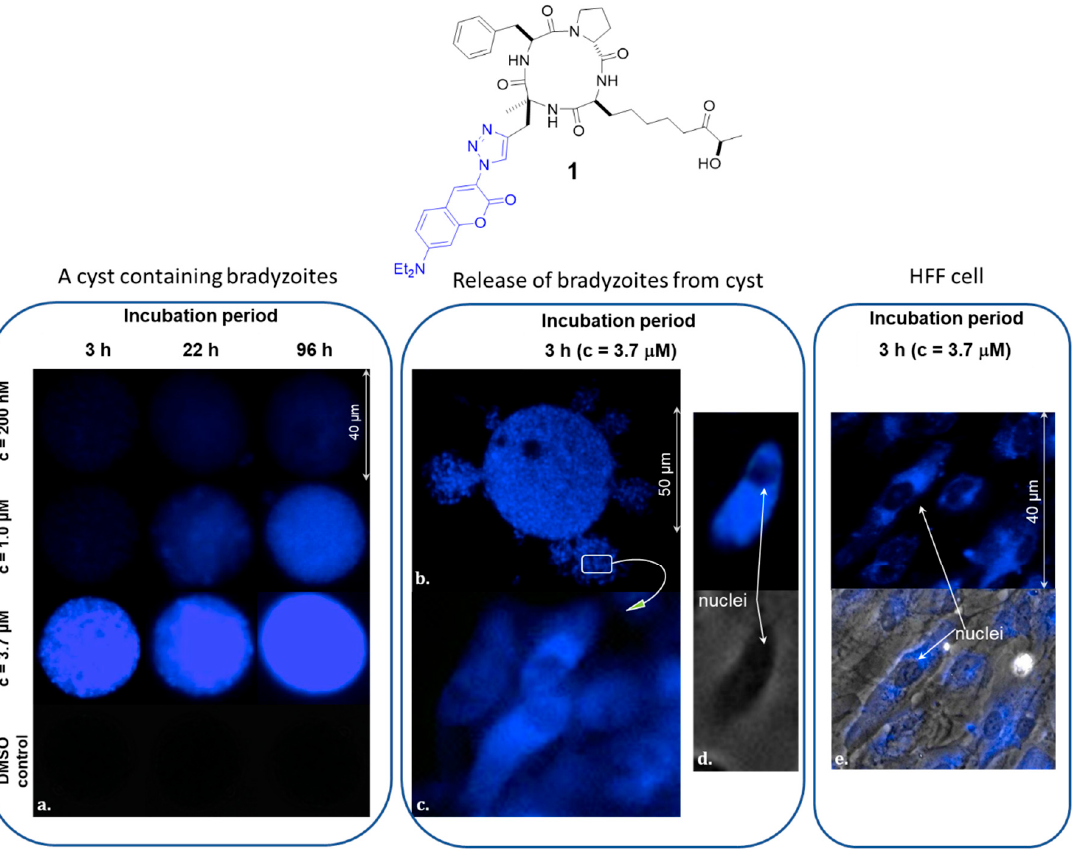
Figure 3. ( a ) Ex vivo T. gondii cysts incubated with compound 1 at a growing concentration (c = 200 nM to 3.7 µ M) for 3, 22 and 96 h, 37 ◦ C, exposure time = 100 ms; ( b ) Cyst treated with 1 (c = 3.7 µ M for 3 h and released from the cyst, 37 ◦ C, exposure time = 100 ms; ( c , d ) Bradyzoites at a higher magnification ( × 100); ( e ) HFF cells treated with 1 (exposure time = 100 ms).